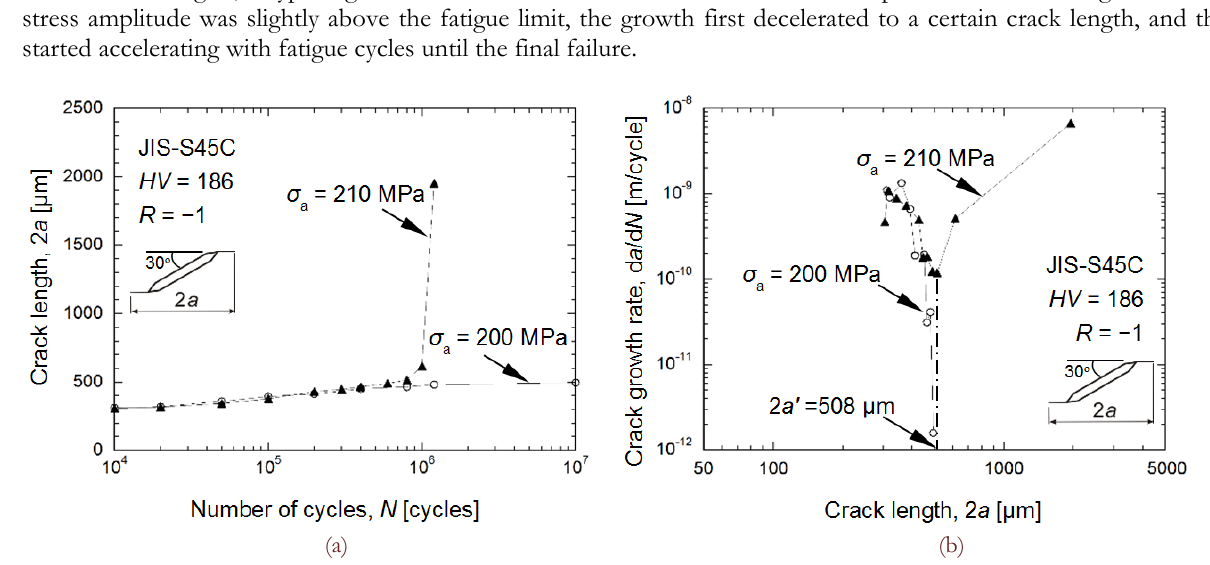
Figure 1: Propagating and non-propagating cracks found above and below the fatigue limit in case of JIS S45C steel and 30º notch (a) crack length vs. number of cycles (b) Crack growth rate vs. crack